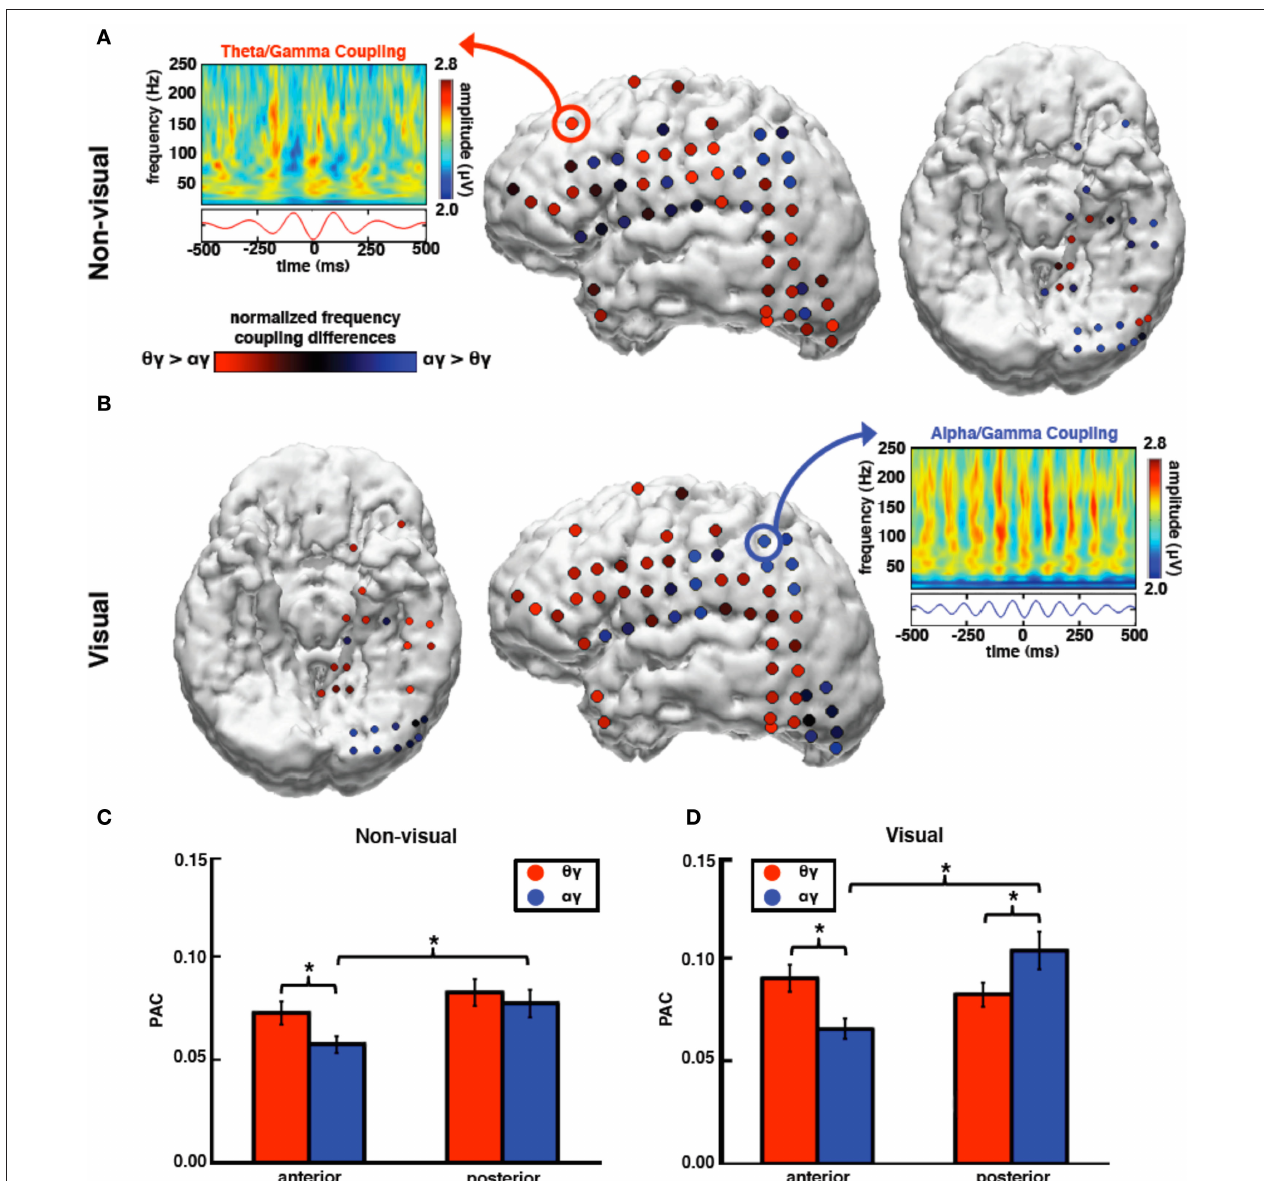
greater than theta PAC. (A,B) Electrode color signifies the low-frequency bias in coupling with high gamma amplitude; red indicates greater theta PAC compared to alpha PAC; blue indicates greater alpha PAC compared to theta PAC. Feature plots are comodulograms at representative electrodes. (C) There is a significant interaction between task, frequency, and topography such that anterior theta PAC is stronger than alpha PAC during non-visual tasks. (D) During visual tasks, however, theta PAC is stronger at anterior electrodes while alpha PAC is stronger at posterior sites. * p < 0.0005, ** p < 0.01 ( t -tests). Error bars represent